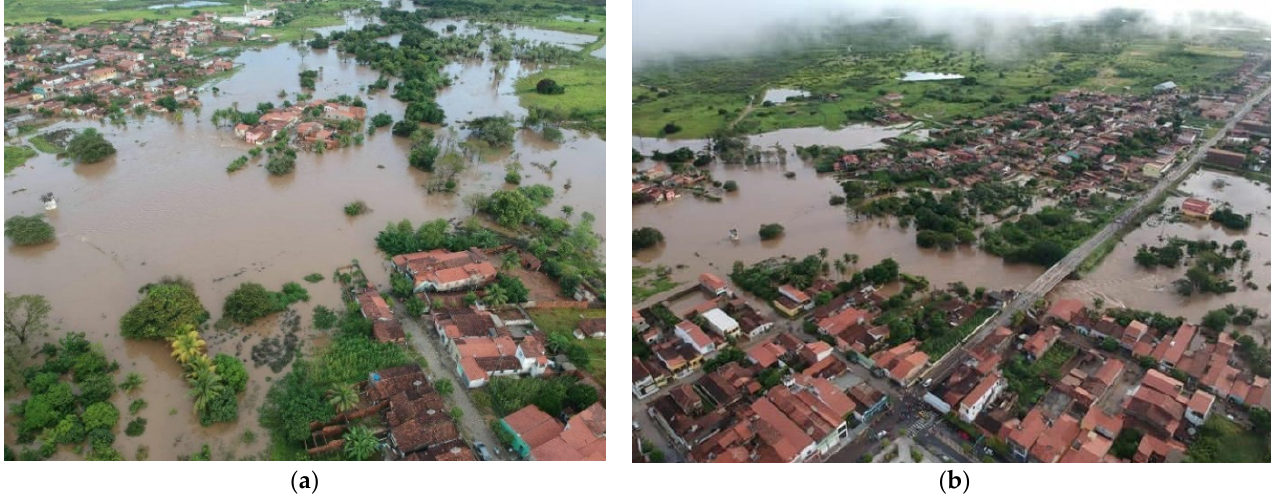
Figure 5. Aerial image of the flood that occurred in March 2020. ( a ) Downstream of the bridge, a neighborhood isolated by the river. ( b ) Aerial view of the city bridge failed to drain the entire volume of water—one part was accumulated on the upstream side.